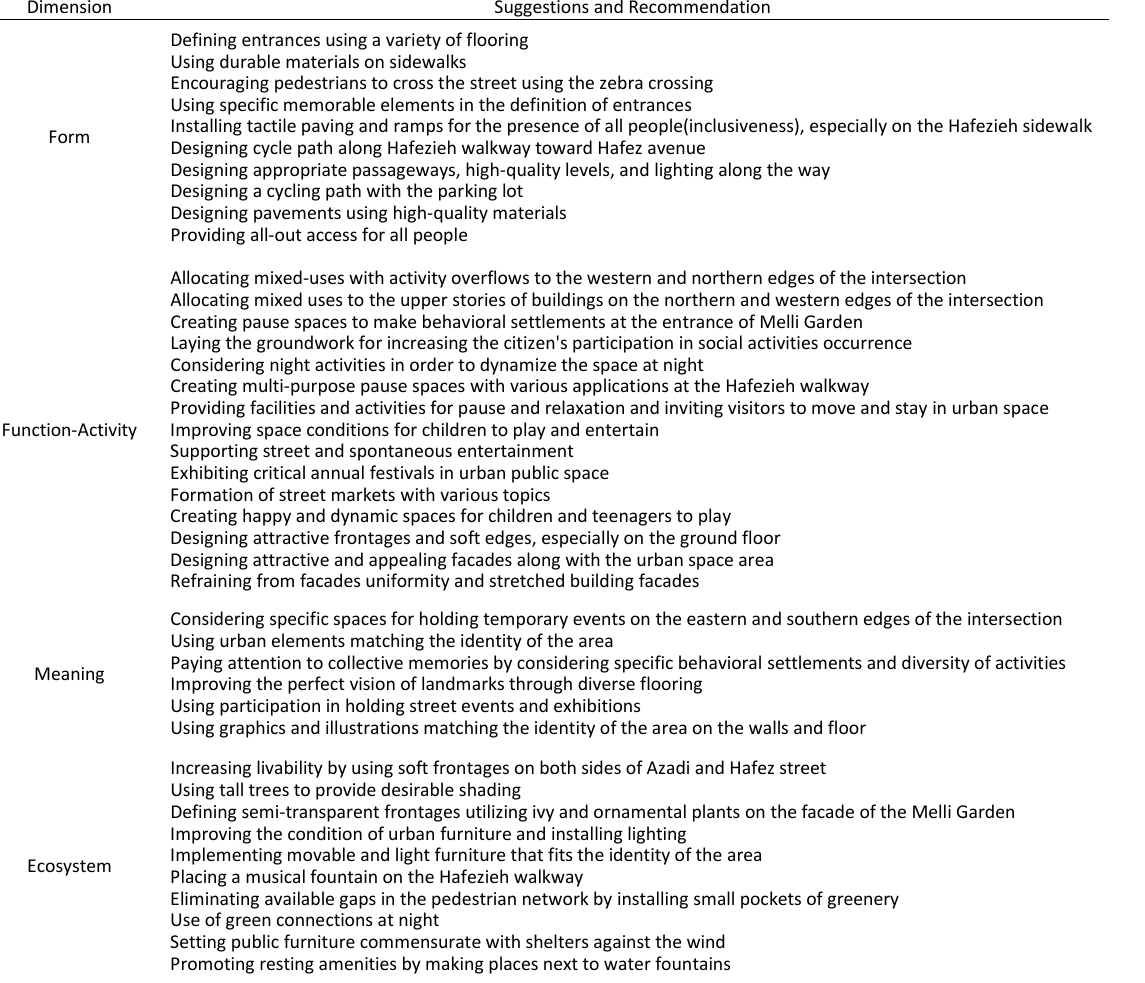
Table. 4: Behavior-based Placemaking Recommendations at the Hafezieh intersection Dimension